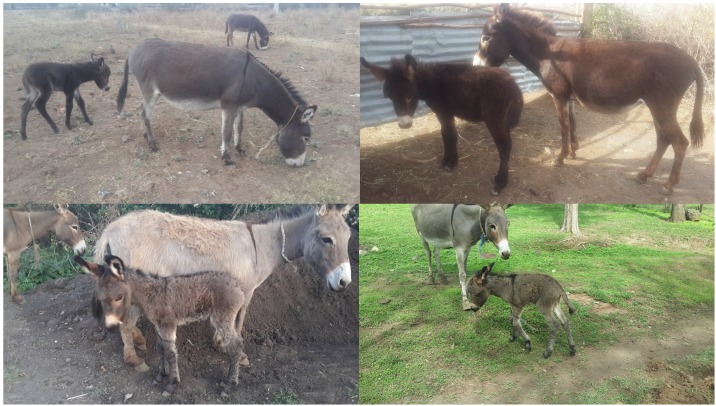
Four of the foals (with their dams) born following artificial insemination performed with frozen-thawed Abyssinian donkey sperm in the present study.No abnormalities were noted in the newborn.